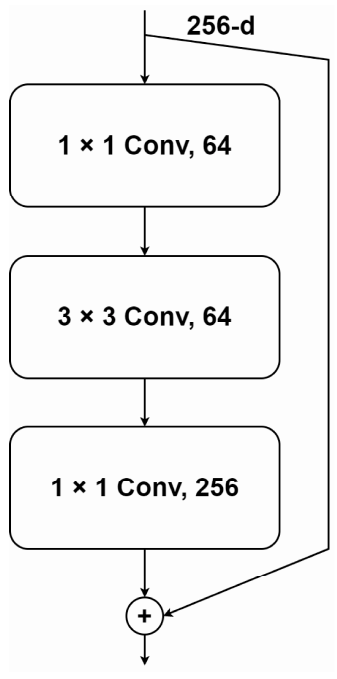
Figure 6. Bottleneck building blocks.